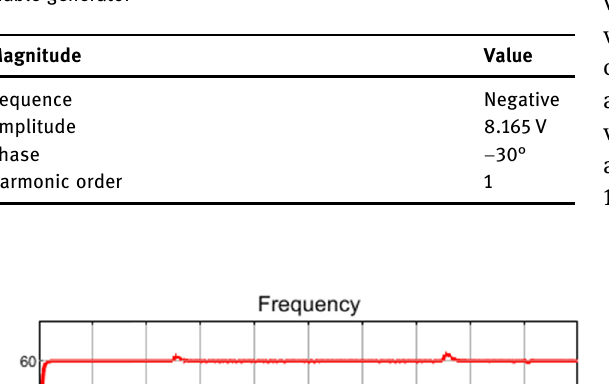
Table 3: Harmonic generation parameters – Three - phase program -